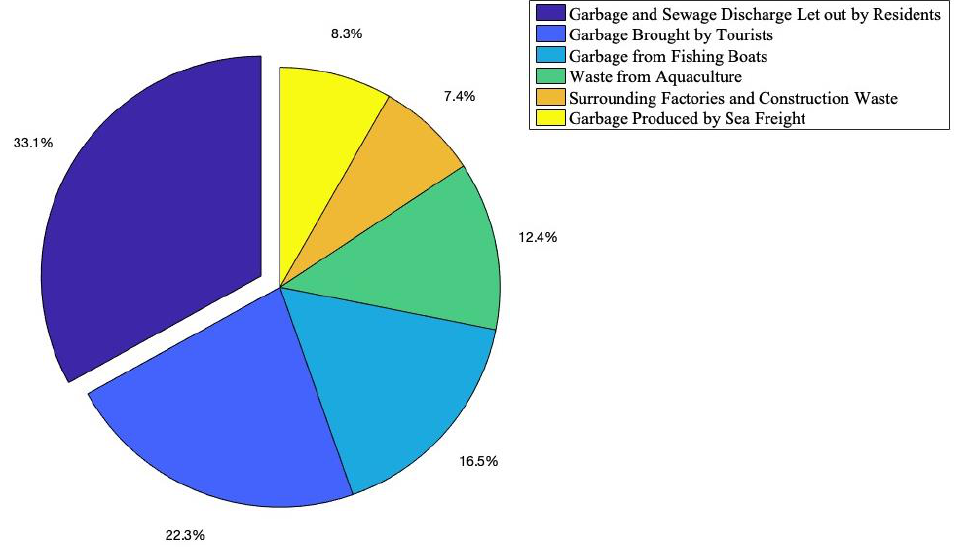
Figure 8. Feedback from tourists and fishermen on the source of litter.